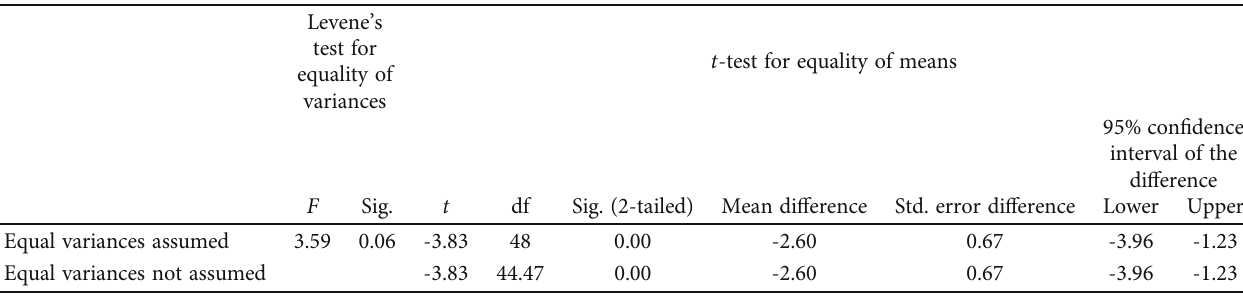
Table 4: Independent sample t -test (immediate posttest of both groups).